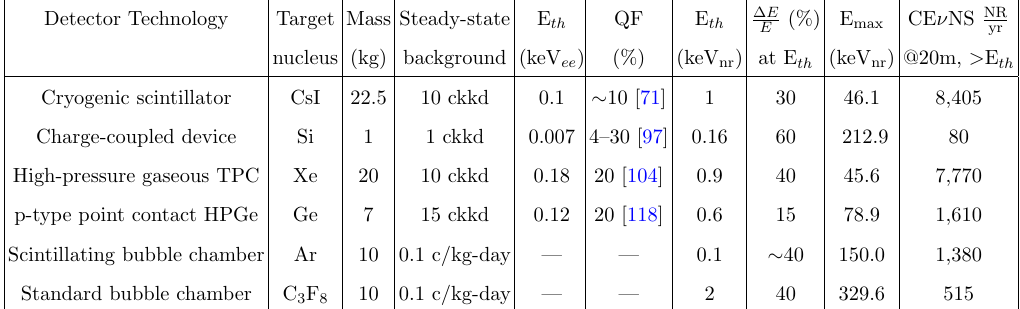
Table 1 . Summary of detector properties, maximum recoil energies considered and expected signal and background rates used in our sensitivity calculations. Backgrounds listed do not include the 4 10 (cid:0) 2 reduction by the ESS duty factor. The germanium QF in [118] will be revisited in (cid:2)